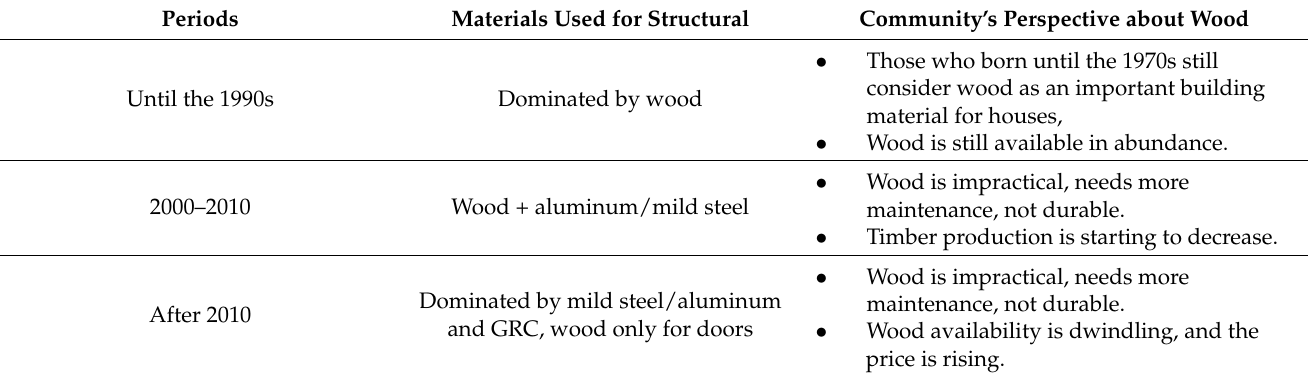
Table 2. The development of materials used for